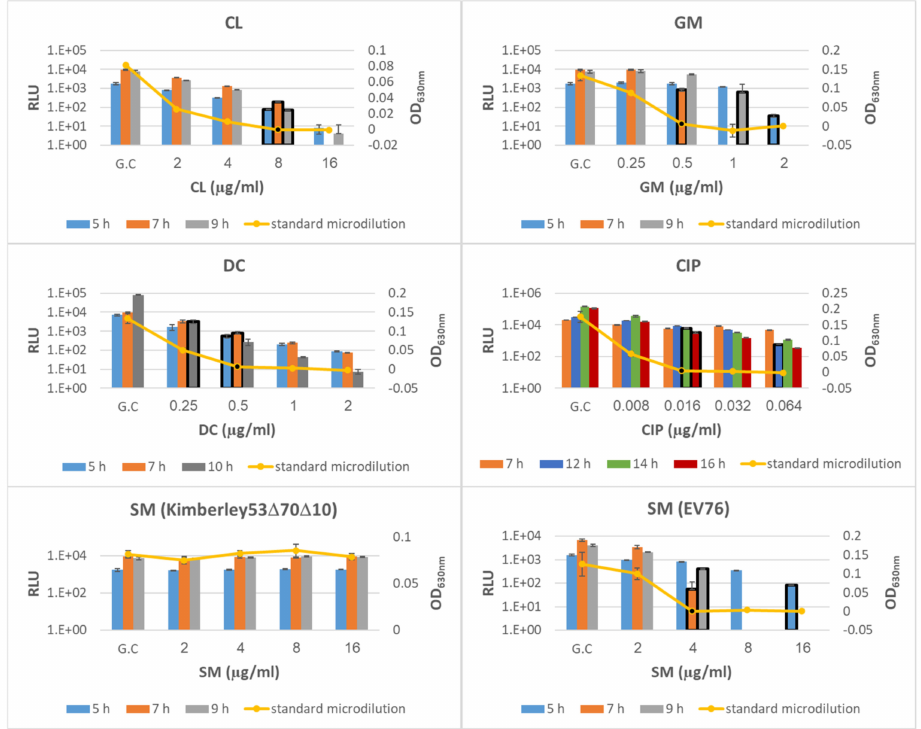
Figure 2. Optimization of the antibiotic exposure period for phage-based AST. Y. pestis strains Kimberley53 ∆ 70 ∆ 10 and EV76 were suspended in MHB to a concentration of ~5 × 10 5 CFU/mL and were tested simultaneously by phage-based and standard microdilution AST. Bacterial suspensions were divided into 96-well microplates (50 µ L/well) already containing 50 µ L of each of 5 different antibiotics—CL (chloramphenicol), SM (streptomycin), GM (gentamycin), DC (doxycycline), and CIP (ciprofloxacin)—at various concentration ranges (detailed in Table 2); the microplates were then incubated at 28 ◦ C. For phage-based AST, exposure periods were as follows: CL, SM and GM were tested at 5, 7 and 9 h of exposure; DC was tested at 5, 7 and 10 h; and CIP was tested at 7, 12, 14 and 16 h. All antibiotics were tested using Kimberley53 ∆ 70 ∆ 10, and SM was also tested using EV76. Each graph displays the resulting bioluminescent signals (RLU; bars) of all exposure times and the OD 630 values obtained in the standard microdilution tests (yellow curve) following 24 h of antibiotic exposure using one bacterial strain exposed to one antibiotic. MIC value obtained in the phage-based AST was determines as the minimal antibiotic concentration that showed a bioluminescent signal lower than 10% of the bioluminescent signal of the growth control. The MIC values obtained by phage-based AST are marked by a black frame around the relevant bar, and the MIC values obtained by the microdilution test are marked by a black dot. Values are the mean results of 3 wells in the same experiment (error bars represent the standard deviation). GC = Growth